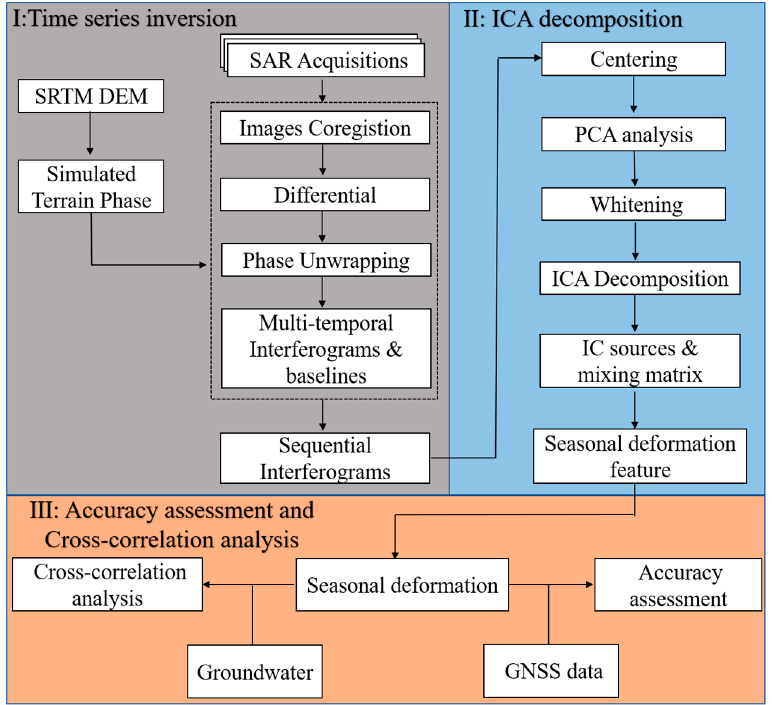
Figure 1. Flowchart of the data processing procedure.